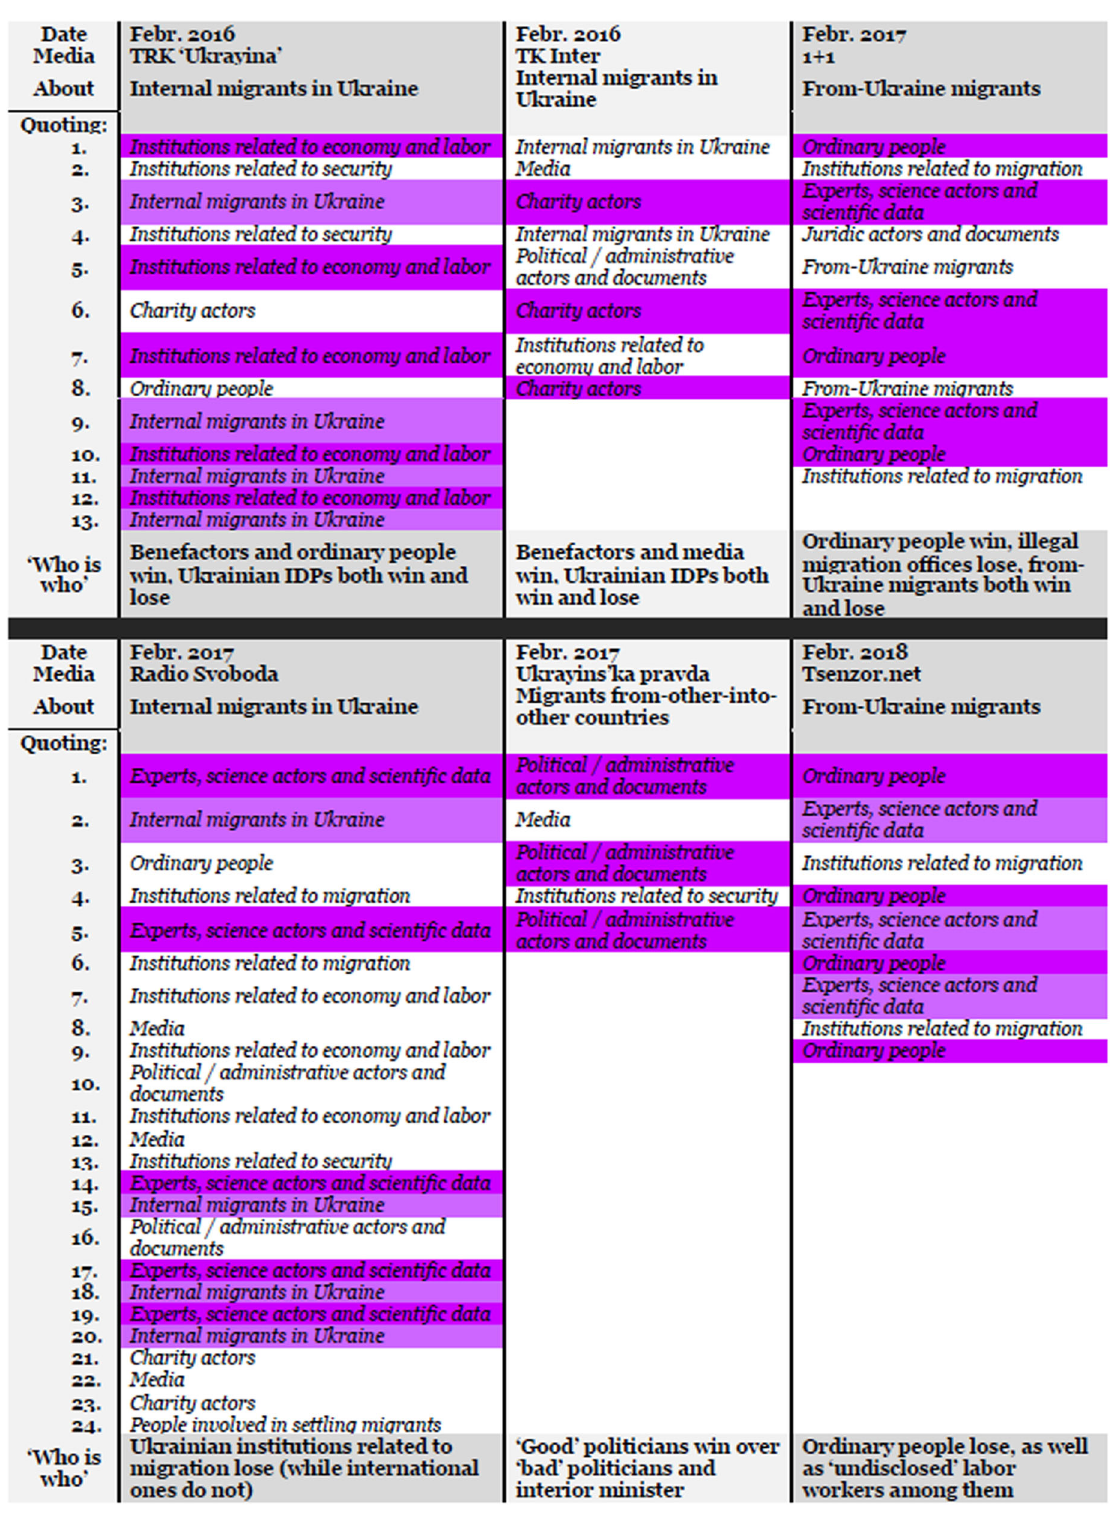
Fig. 7 Examples of message quotation hierarchies in different audiovisual types (TV — upper part; Internet — bottom part) of Ukrainian top media (2015 – 2018, sample from every February messages). Source: A. Tashchenko ’ s elaboration based on qualitative content analysis (by L. Yuzva and A. Tashchenko), analysis of discourse positions and sociocognitive critical discourse analysis (by A. Tashchenko) of media messages. Data source: The Center for Content Analysis research based on quantitative media content analysis, 2019. The comparative illustration shows the groups of actors quoted directly or indirectly in six selected media messages and what order they were quoted in. The names of groups of actors most-often-quoted are highlighted in lilac, the names of groups of actors that came second in terms of quotation frequency are highlighted in light lilac. All other colors are used to delimit areas for the sake of visual convenience. The ‘ Who is who ’ lines describe groups of actors implicitly presented in favorable or unfavorable light.